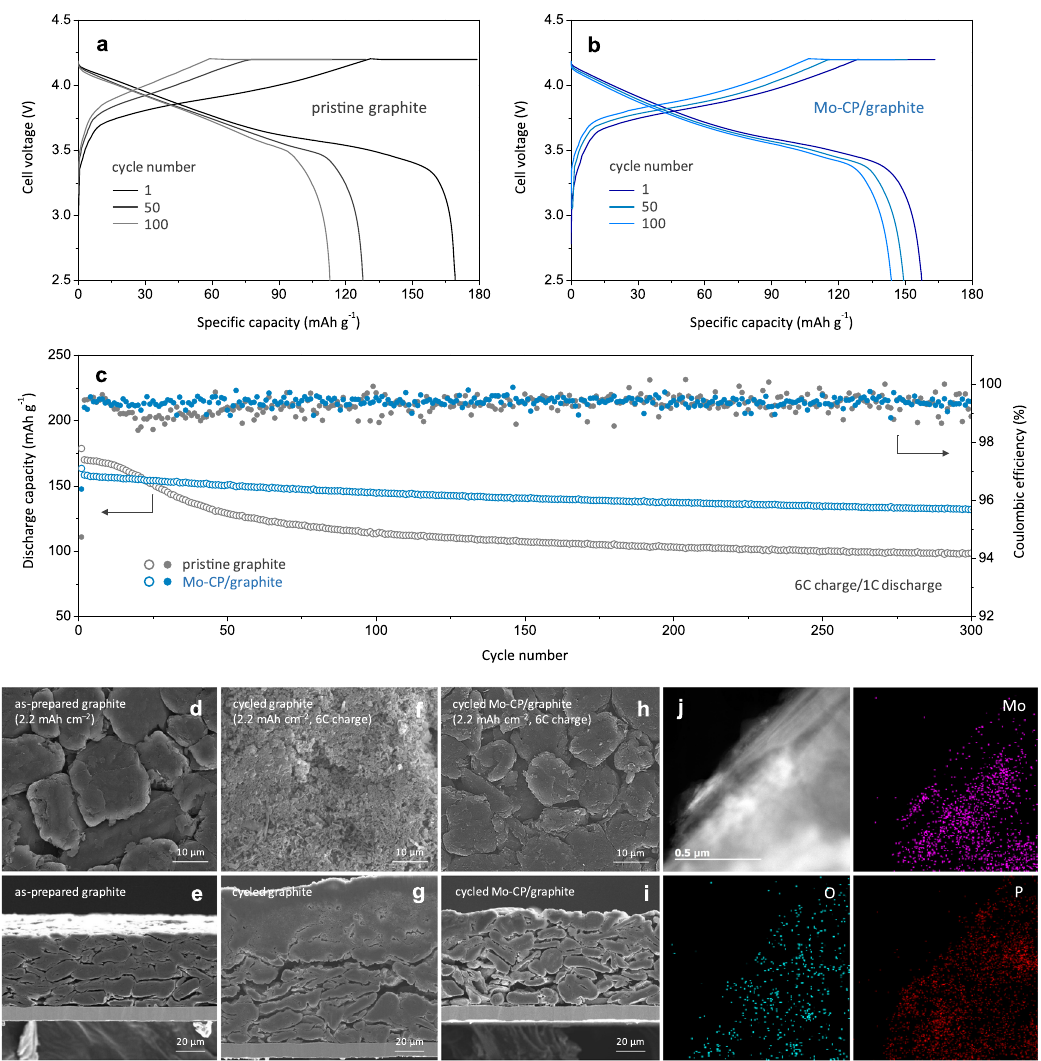
Fig. 5 Cycling performance of Mo-CP/graphite under fast-charging conditions. a , b Voltage pro fi les of full cells assembled with pristine graphite ( a ) and 2 wt% Mo-CP/graphite ( b ) anodes at selected cycles. c Capacity decay and CEs of full cells with pristine graphite and Mo-CP/graphite anodes. Cycling was performed at charge/discharge rates of 6 C/1 C. d – i Surface ( d , f , h ) and cross-sectional ( e , g , i ) FESEM micrographs of as-prepared graphite ( d , e ), cycled graphite ( f , g ), and cycled Mo-CP/graphite ( h , i ) anodes. j TEM and EDS mapping results of Mo-CP/graphite after 300